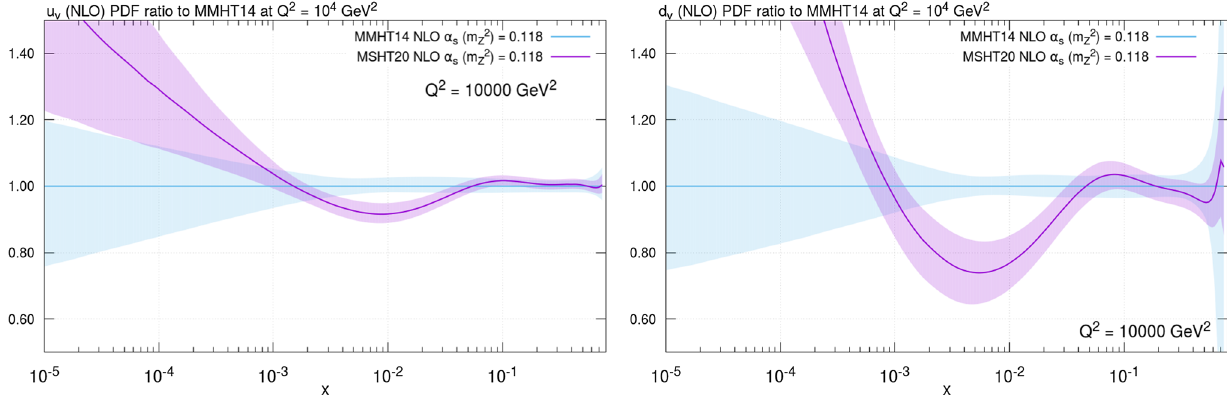
NNLO version in Fig. 22 (right), but the up valence shown in Fig. 35 (left) actually gets further away from MMHT14 at NLO than at NNLO (Fig. 22 (right)). Hence, at NLO a sim- ilar change in shape of both valence quarks cancels to some extent in their